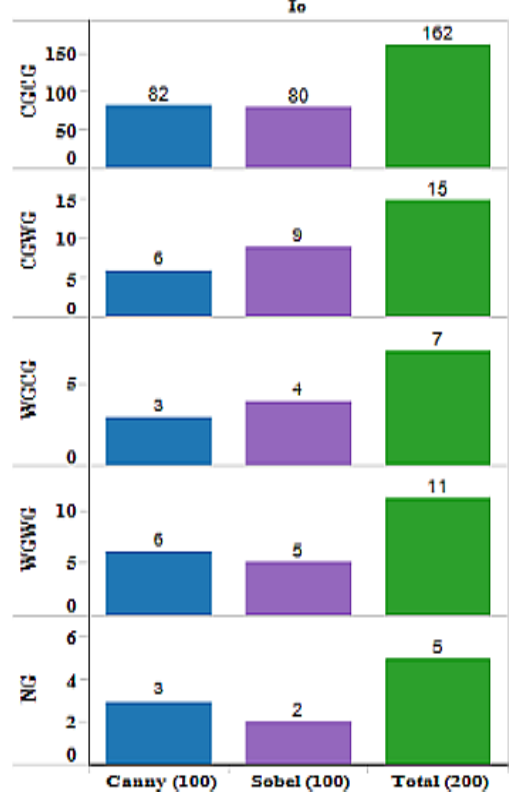
Figure 8: Comparative analysis of canny and sobel edge detectors using proposed GDE algorithm on the basis of glint coordinates and gaze direction estimate of different input